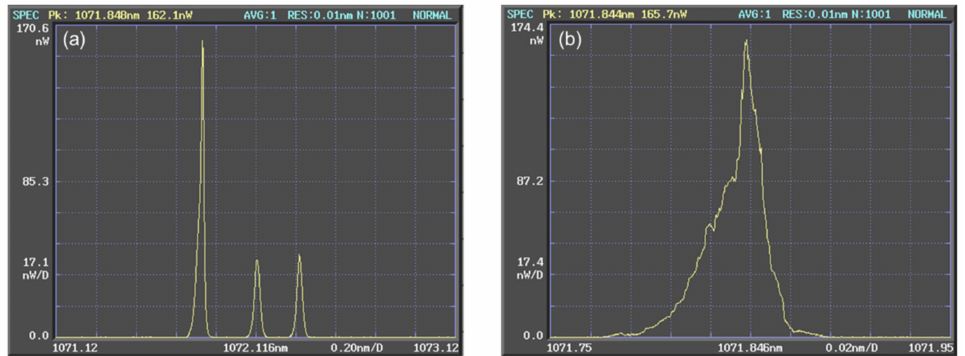
Figure 3. ( a ) Simultaneous generation of three wavelengths without four-wave mixing (0.20 nm/div). ( b ) Magnified view of only one wavelength (0.02 nm/div). The line width is thick and no single-mode oscillation is observed.